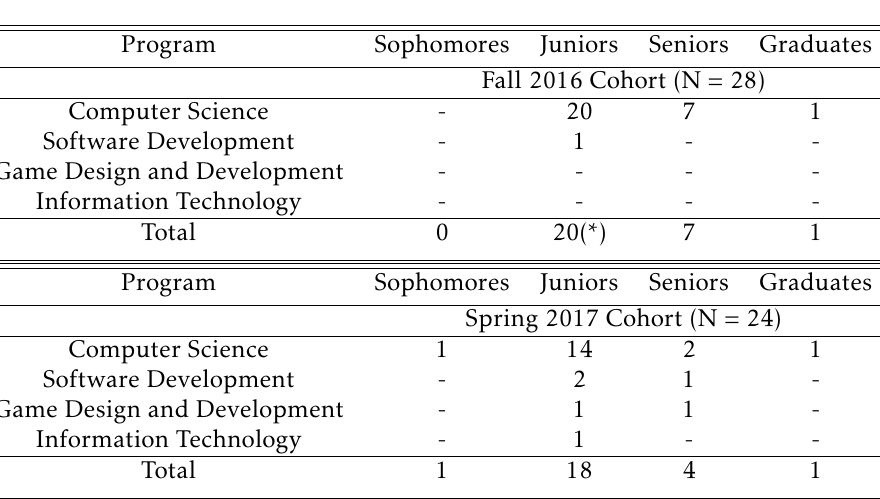
Table 3. Programs of Study by Year and Number of